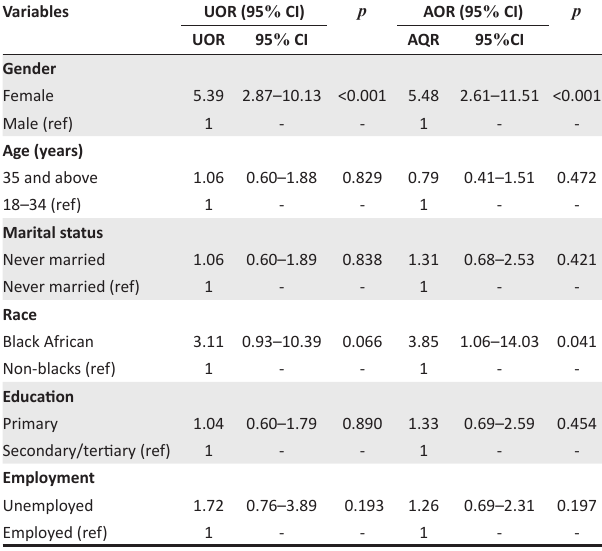
TABLE 4: Binary logistic regression showing correlates of HIV co-morbidity.